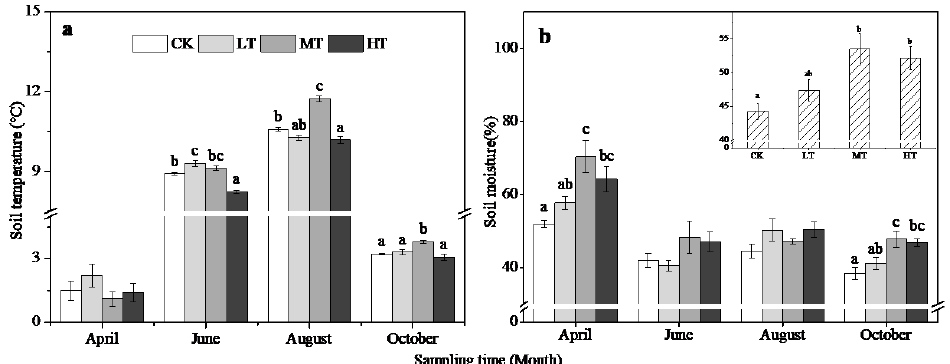
Figure 7. Effects of thinning treatments on soil temperature ( a ) and moisture ( b ) at various sampling times in L. principis-rupprechtii plantations. CK, control site; LT, light thinning; MT, moderate thinning; HT, high thinning. Values within each sampling time followed by different letters differ significantly according to Tukey's test ( p <0.05). When the difference was not statistically significant, no letter notation was noted.